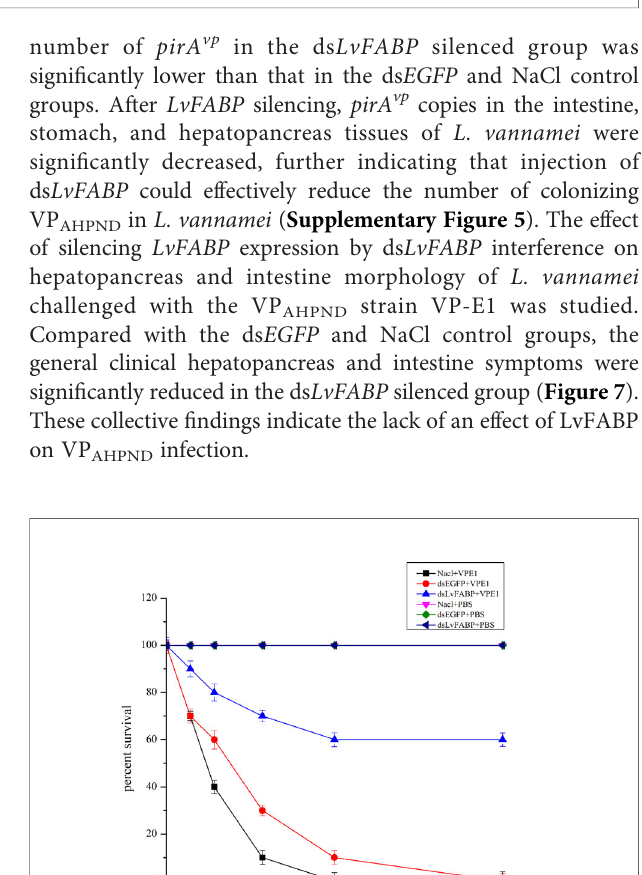
FIGURE 3 | Expression of LvFABP in different tissues and hepatopancreas at different periods of L. vannamei. (A) : the expression of LvFABP in different tissues of L. vannamei , the intestine, stomach, and hepatopancreas were collected to analyze; (B) : the hepatopancreas at different periods of L. vannamei were collected to analyze the expression of LvFABP at different developmental stages. Each bar represents the mean ± standard deviation (SD) of triplicate experiments. Different letters indicated signi fi cantly difference (P